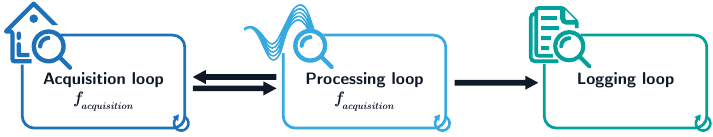
Figure 5. Main loops governing the IMPEC standalone application.